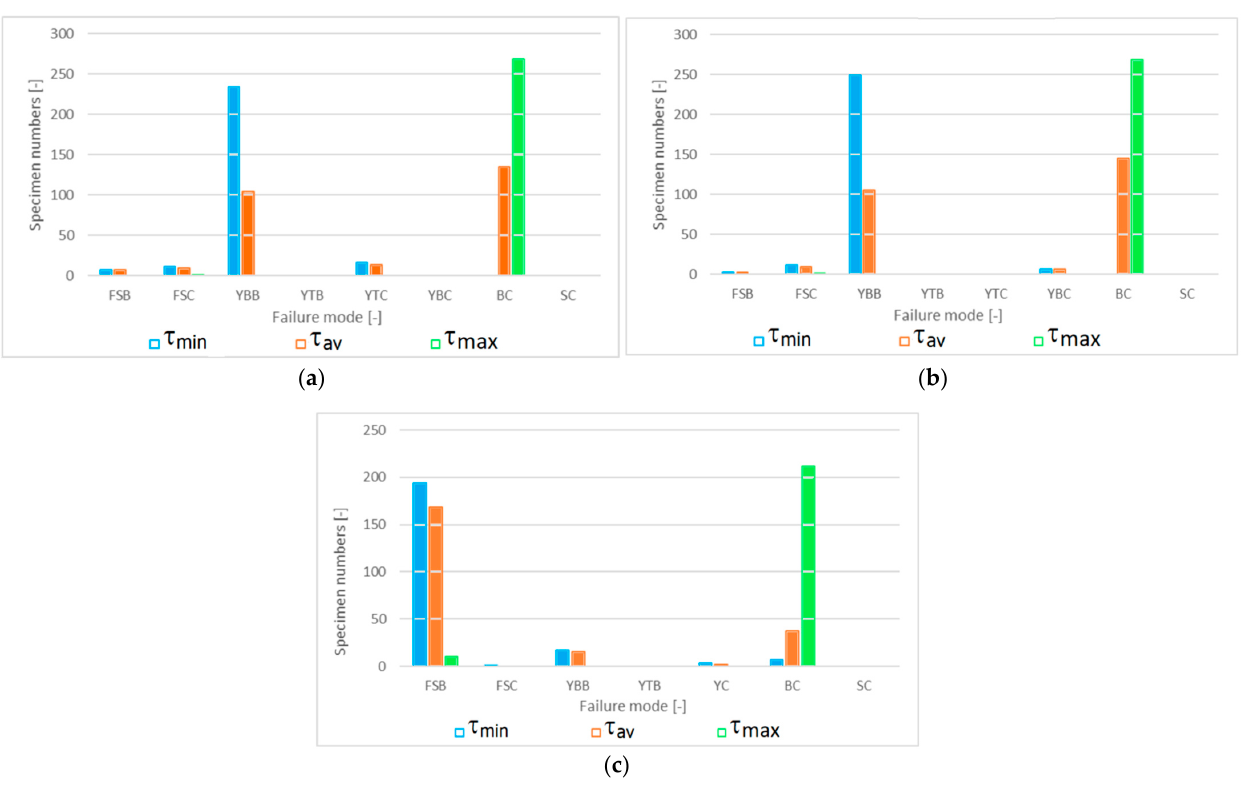
Figure 10. Failure mode as the bond stress changes: ( a ) T-shaped RC joints under positive column shear, ( b ) T-shaped RC joints under negative column shear, and ( c ) X-shaped RC joints.